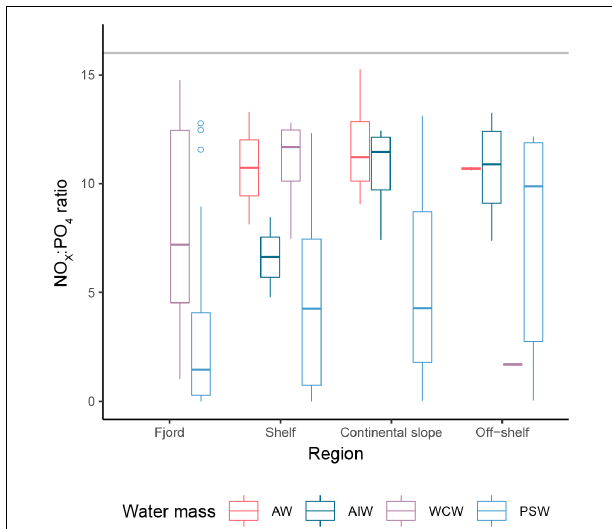
FIGURE 6 | Nitrogen/phosphorous ratio (NO x :PO 4 ) in different water masses (AW, Atlantic Water; AIW, Atlantic Intermediate Water; WCW, Winter Cooled Water; PSW, Polar Surface Water), along the Rijpfjorden transect. The horizontal gray line indicates the Redfield